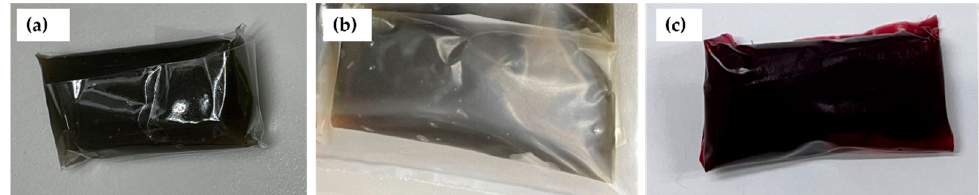
Figure 2. Coconut milk candy wrapped in PP film ( a ), Control (0% DPE) biocomposite film ( b ), and 2% DPE-enriched biocomposite film ( c ).